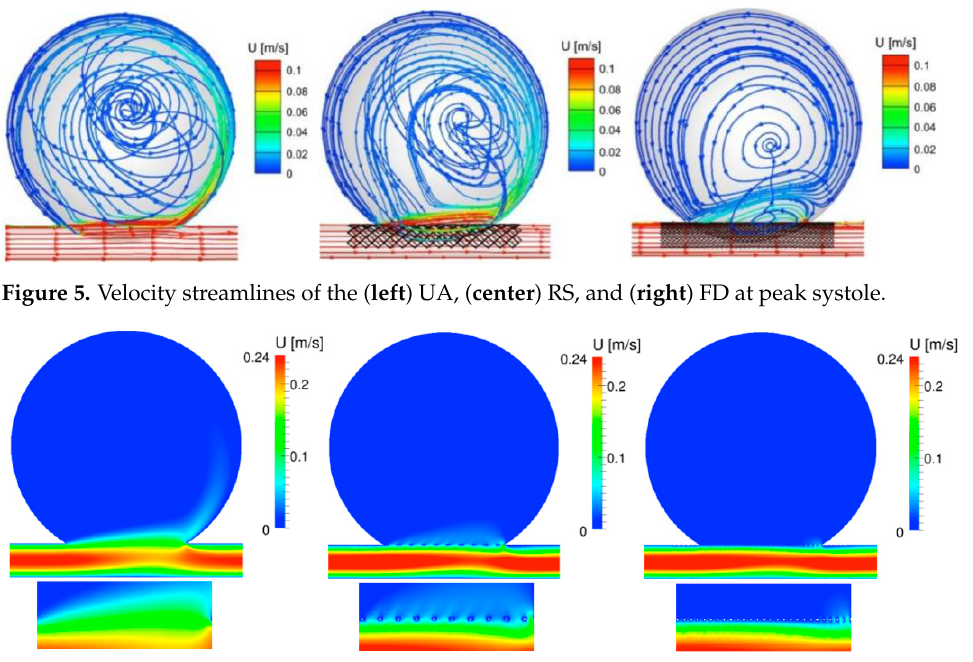
Figure 4. Velocity contour at the mid plane ( top ) and the zoom view of the velocity contour ( bottom ) of the UA ( left ), RS ( center ), and FD ( right ) at peak systole.